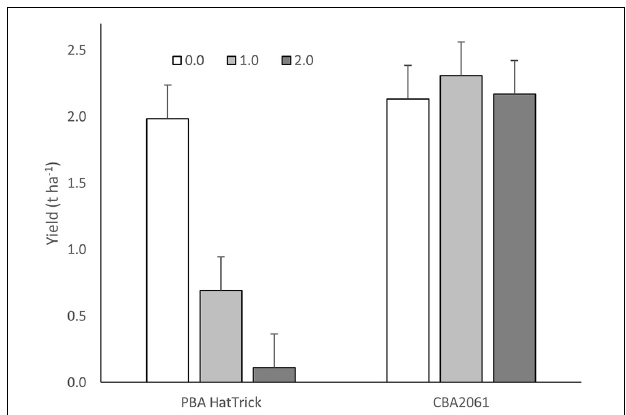
FIGURE 4 | Yield response of CBA2061 compared to cv. PBA HatTrick following application of the recommended field use rate of 24.8 g a.i. ha – 1 of imazamox + 11.3 g a.i. ha – 1 of imazapyr and twice the recommended rate in the 2020 field trial at Turretfield, SA. Bars indicate means and whiskers indicate LSD ( α =